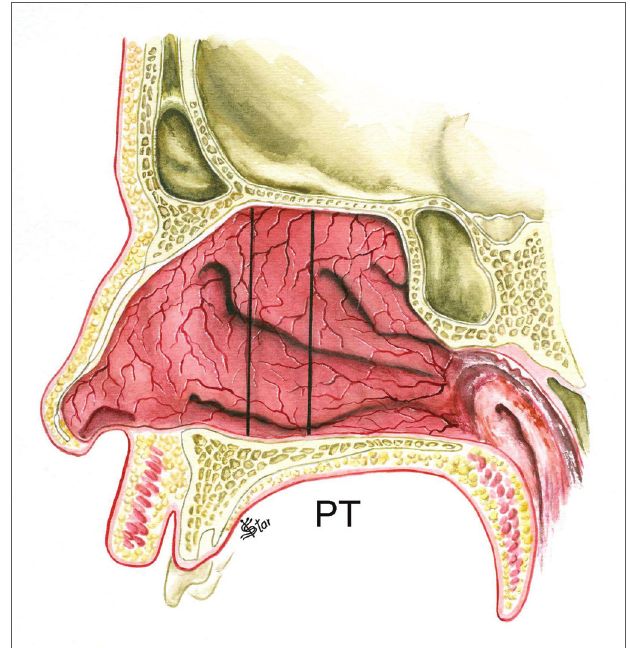
Figura 7. Estadiamento da PN no plano ântero-posterior - PT - pólipos ocupando toda extensão ântero-posterior da fossa nasal